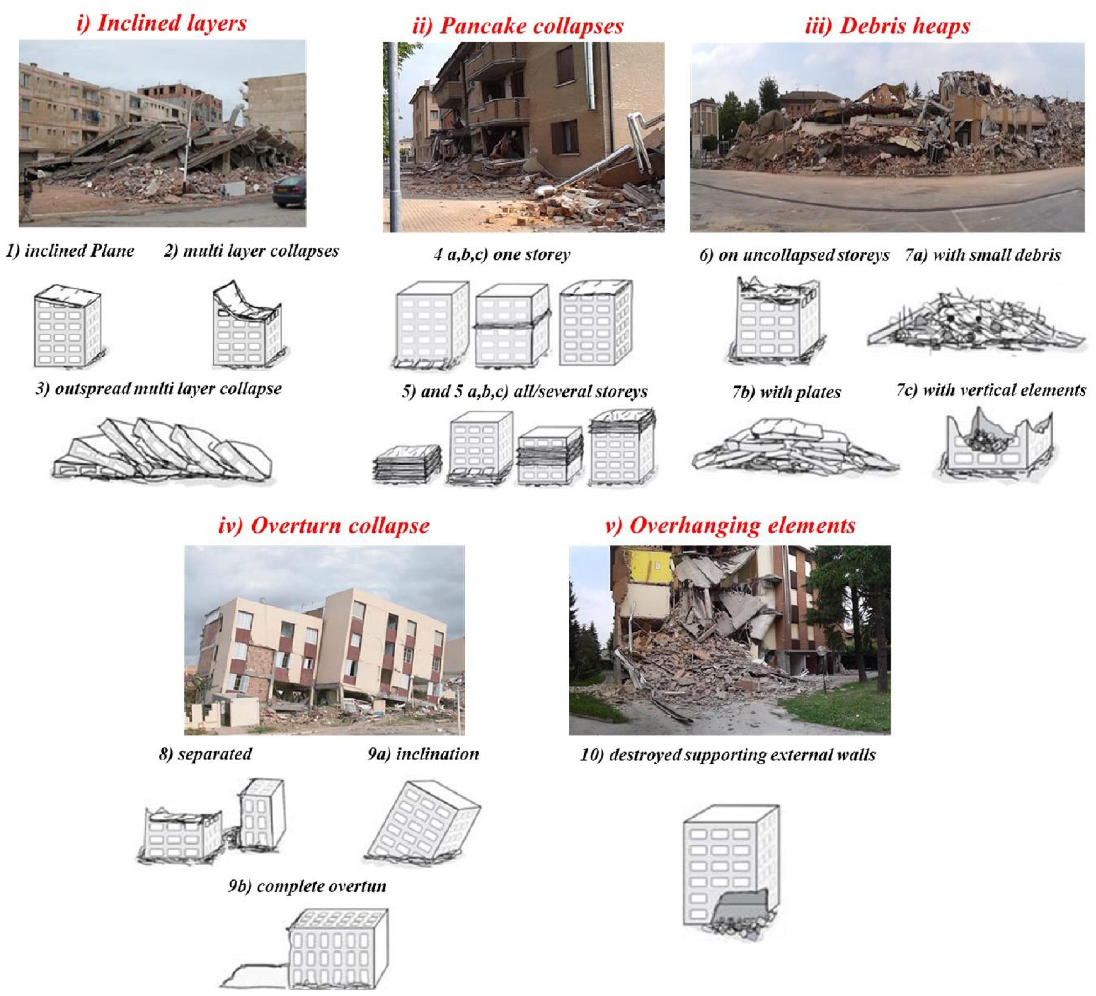
Figure 2. Classification of collapsed buildings as reported in Schweier C. and Markus M. [5].